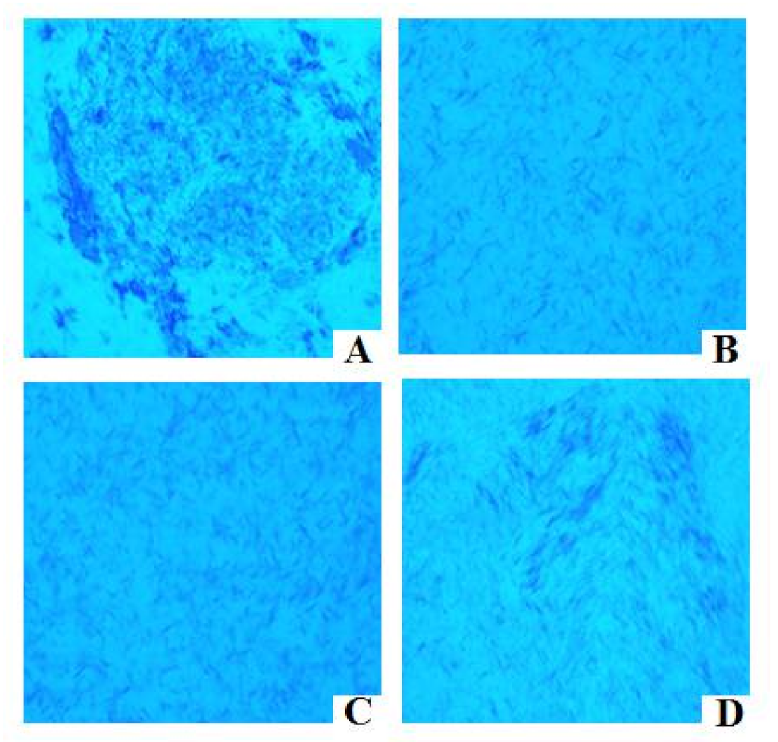
Figure 4. Wax crystal in saturated hydrocarbon with ( A ) Blank, ( B ) CA C H, ( C ) CA R H, and ( D ) CA S